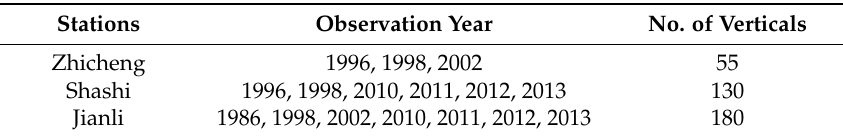
Table 1. Statistics of data measured at the JJRR (following [17]).